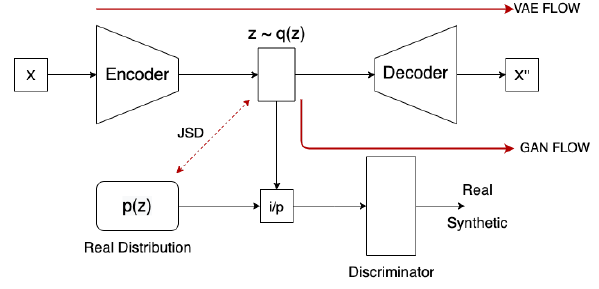
Figure 1. Architecture of 3dAAE